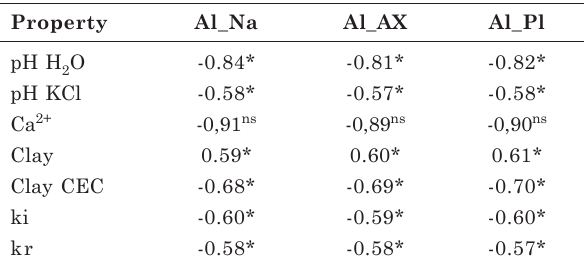
* significant at 1 %; ns: not significant.